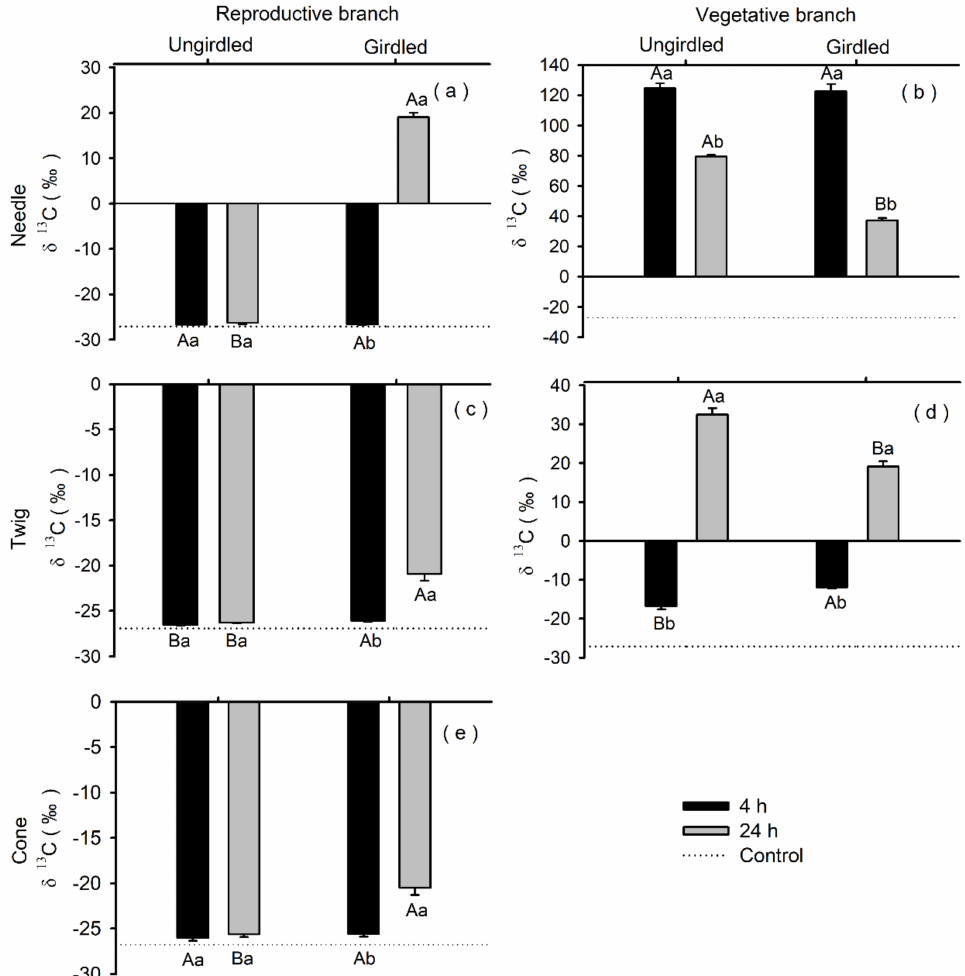
Figure 5. Carbon isotopic composition ( δ 13 C) in needle ( a , b ), twig ( c , d ), and cone ( e ) tissues after 4 h and 24 h of the 13 CO 2 labeling pulse to which vegetative branches of Pinus koraiensis were subjected. Each tandem of branches was girdled or remained ungirdled ( n = 6). Dotted lines indicate the baseline δ 13 C measured in unlabeled trees (control). Bars and arrows represent the mean and corresponding standard error. Different capital letters indicate significant differences between girdling treatment levels for a given harvesting time ( p < 0.05). Different lowercase letters indicate significant differences between harvesting times for a given girdling treatment ( p < 0.05). Means were compared using LSD